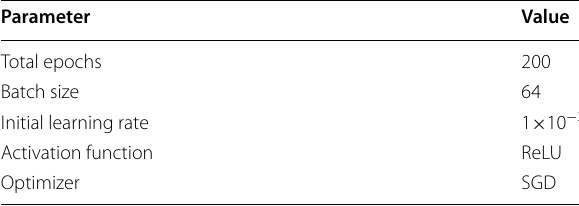
Table 2 Hyper-parameters for the training of our